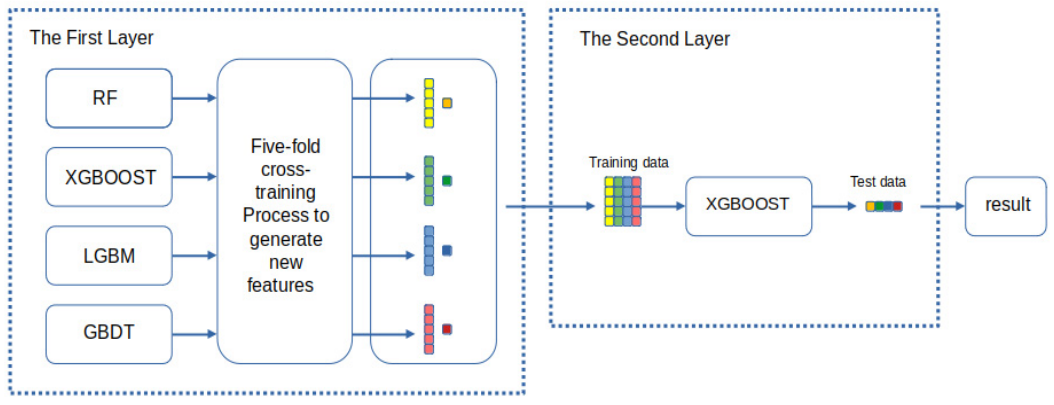
Figure 3. Structure of a two-layer stacking model.